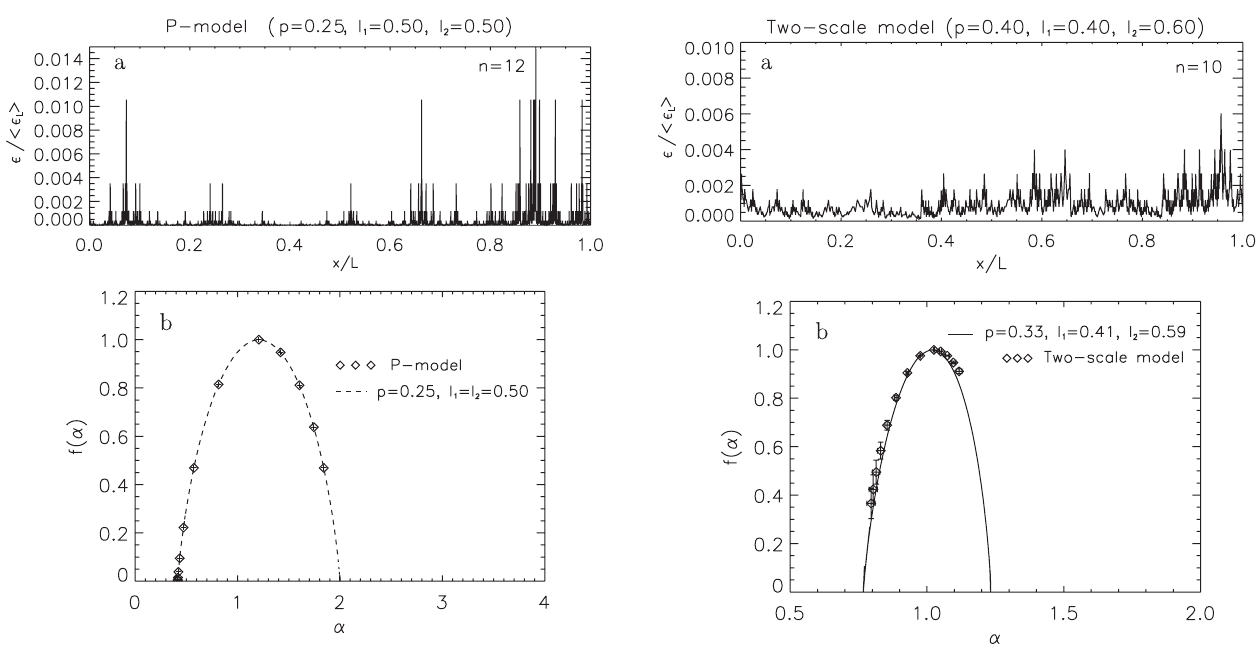
Fig. 2. (a) The theoretical multifractal measure µ = ε/ h ε L i on the unit interval for the tenth step of the construction of the weighted two-scale Cantor set. (b) The multifractal spectrum f (α) obtained directly for this measure (diamonds) with a fit (continuous line) to the generalized p